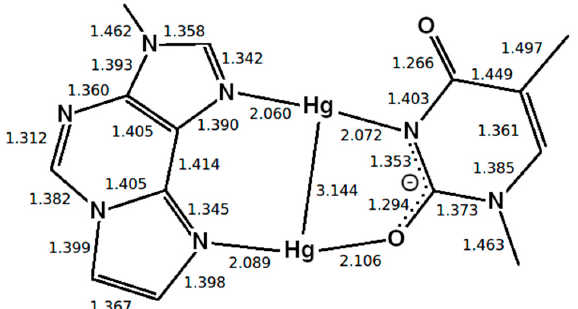
Figure 5. Optimized structure of the ε A –Hg(II) 2 – T base pair with interatomic distances in Å, where the presence of neighbouring base pairs was taken into consideration, too. Only the metal-mediated base pair is shown. The mercury(II) previously attached to T -O4 changes its bonding pattern, now being located between two nitrogen atoms ( NN -bonding pattern).